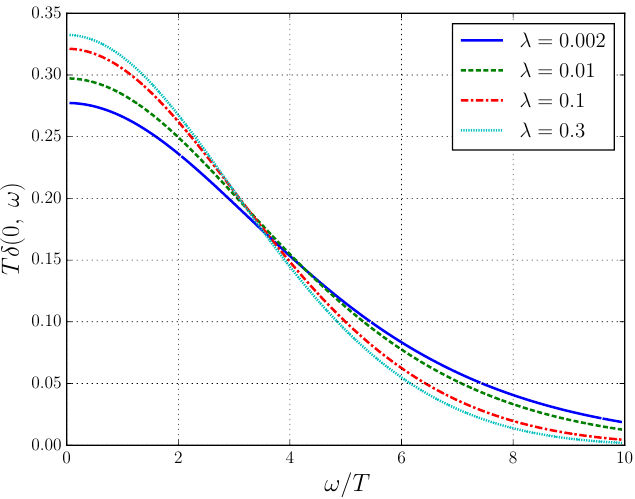
Figure 2 . The resolution function at the temperature T=T c = 1 : 35 and (cid:22) ! = 0 for various values of the (cid:21)